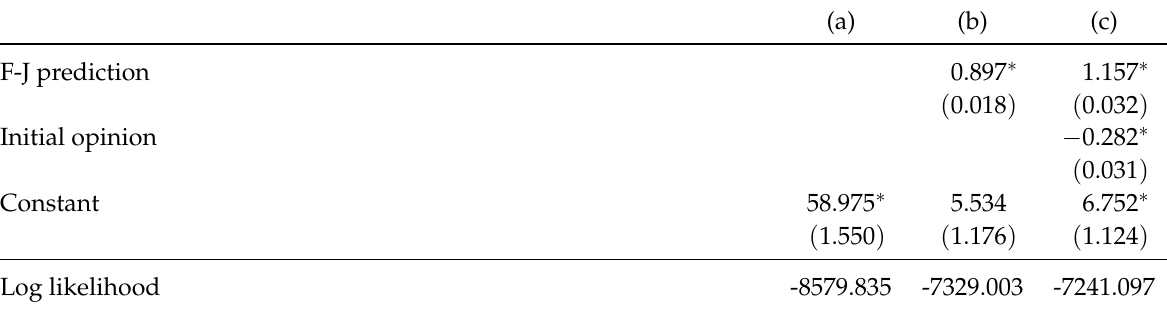
Table 1: Prediction of an individual’s final opinion on an issue. Opinions are scaled 0 − 100. Standard errors are in